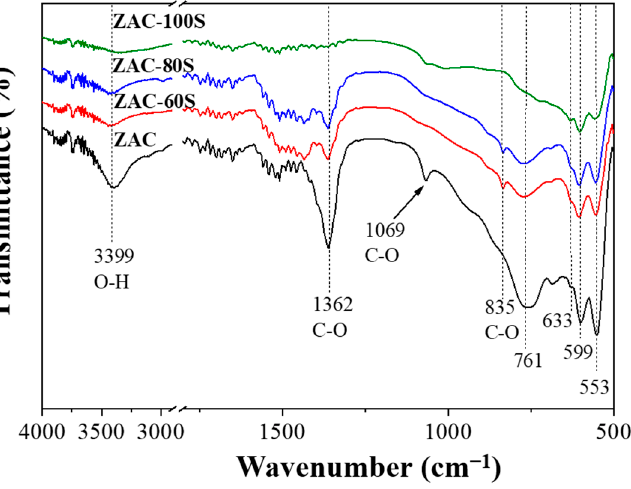
Figure 4. Fourier Transform Infrared Spectra for the samples ZnAl-LDH samples and ZAC-100S.